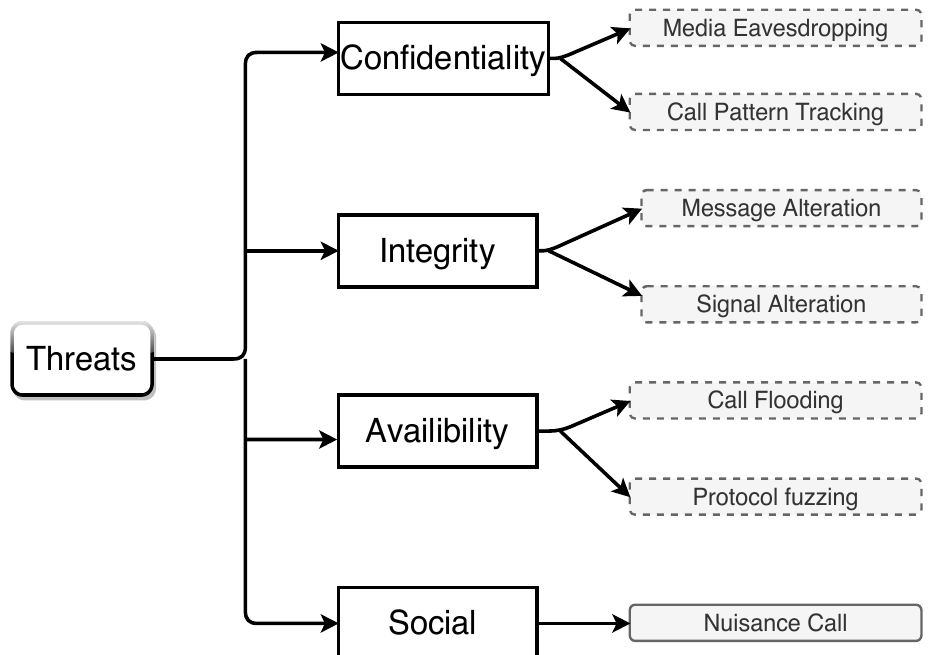
Figure 1. Taxonomy of Internet Telephony